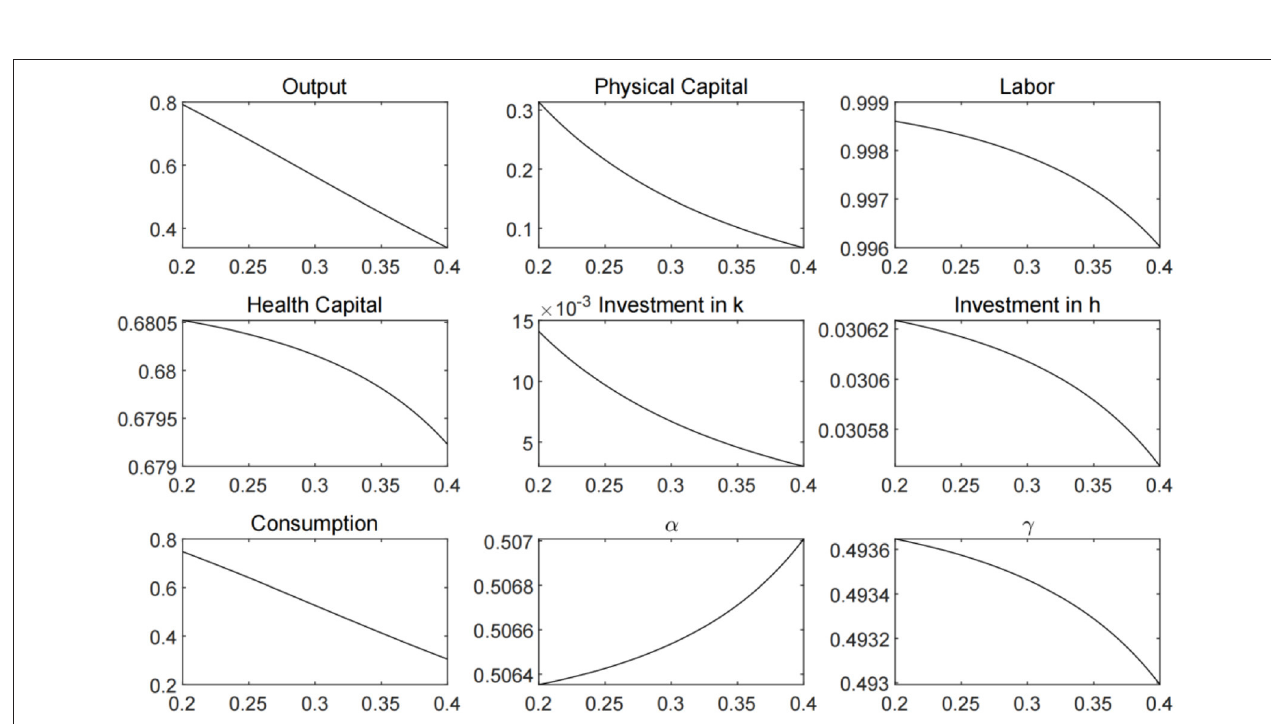
FIGURE 7 | Economic steady state under different capital